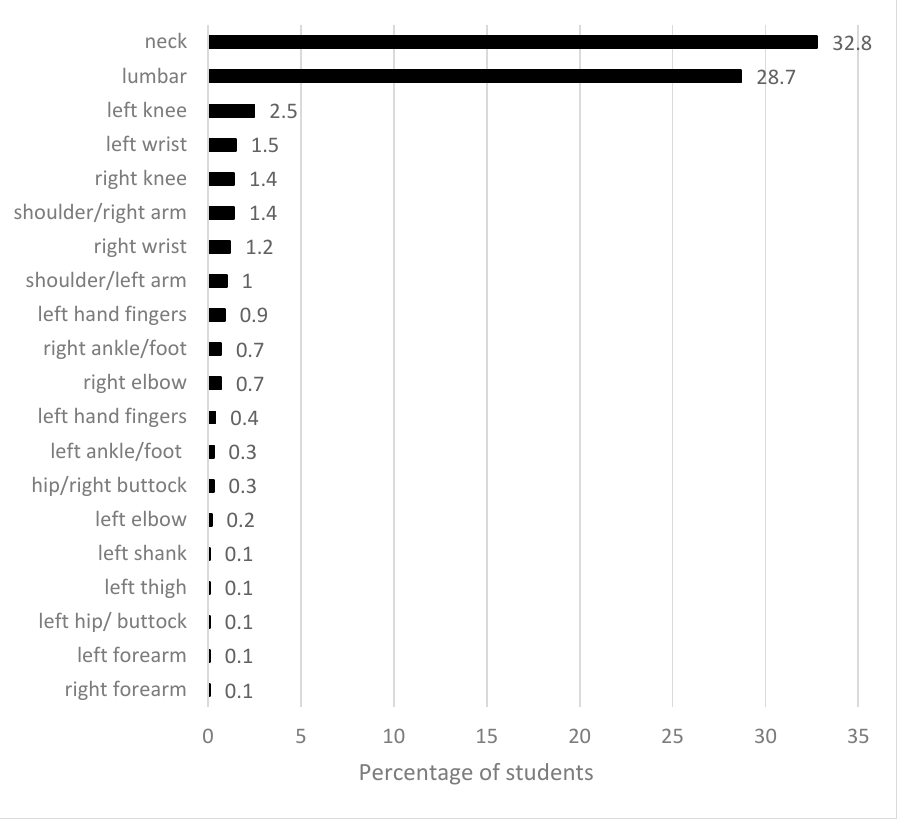
Figure 1. Location of dominant musculoskeletal complaints during the COVID-19 pandemic. Moderate or higher levels of stress were reported by more than 80% of students, regardless of the study period ( p > 0.05) (Table 1). During the pandemic, the number of headache sufferers as well as the level of severity of headaches increased from 71% to 78% ( p < 0.001) and from 3.1 ± 2.6 to 3.8 ± 4.2 points ( p < 0.001), respectively. The percentage of